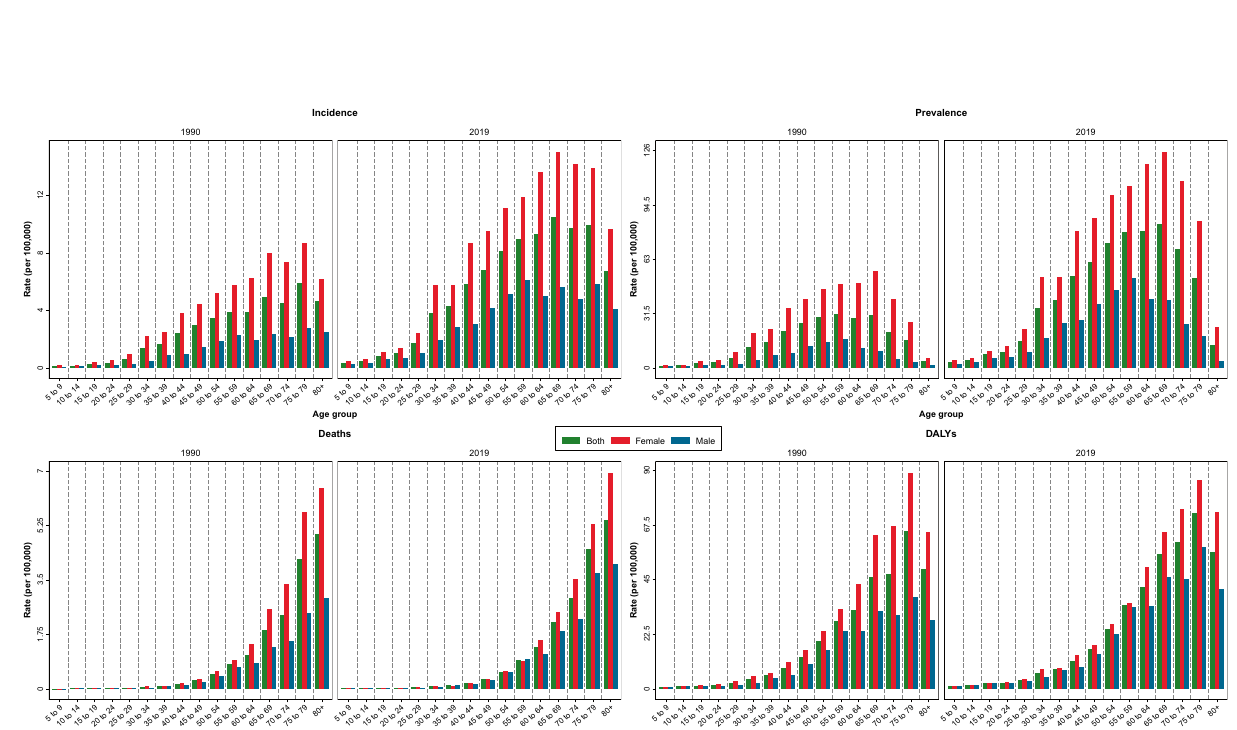
Figure 2. Thyroid cancer incidence, prevalence, deaths, and DALYs by age groups in 1990 and 2019 by